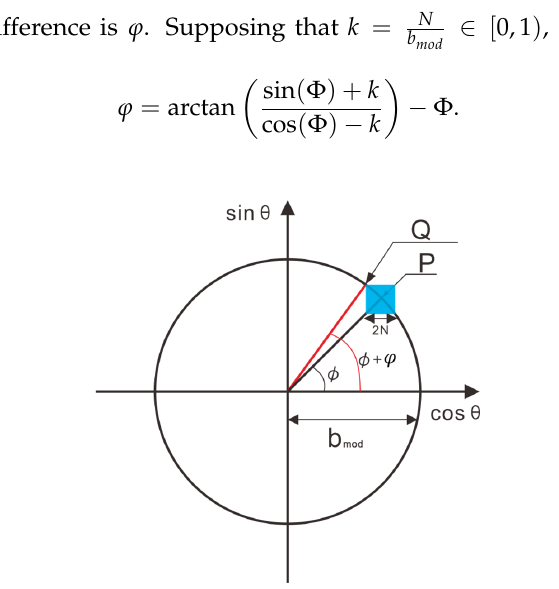
Figure 4. Error analysis in fringe projection profilometry